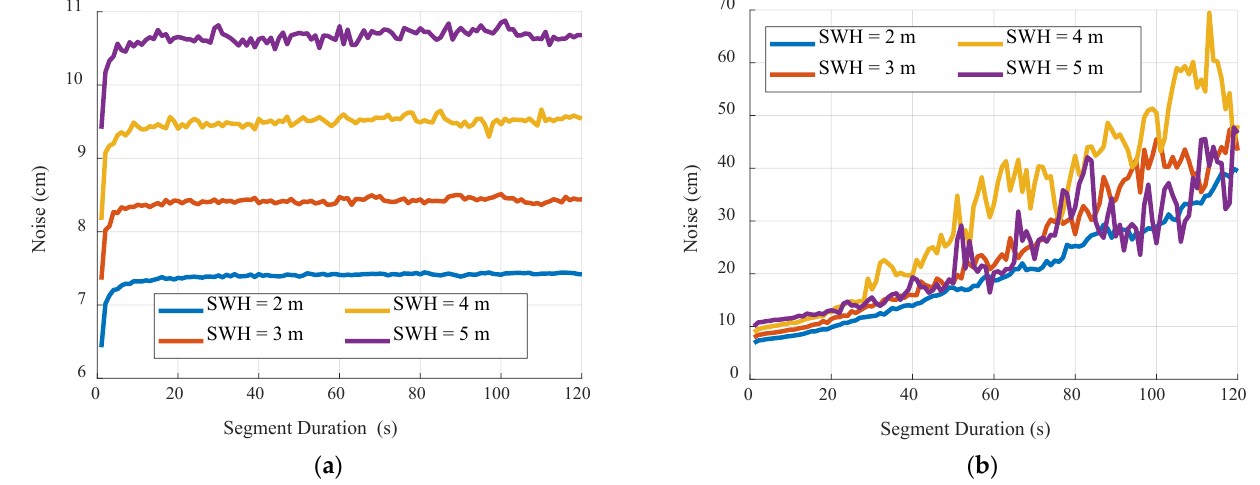
Figure 6. The statistical relationships between the NL estimated using ( a ) differential and ( b ) non-differential methods and the segment duration with an SWH of 2–5 m.